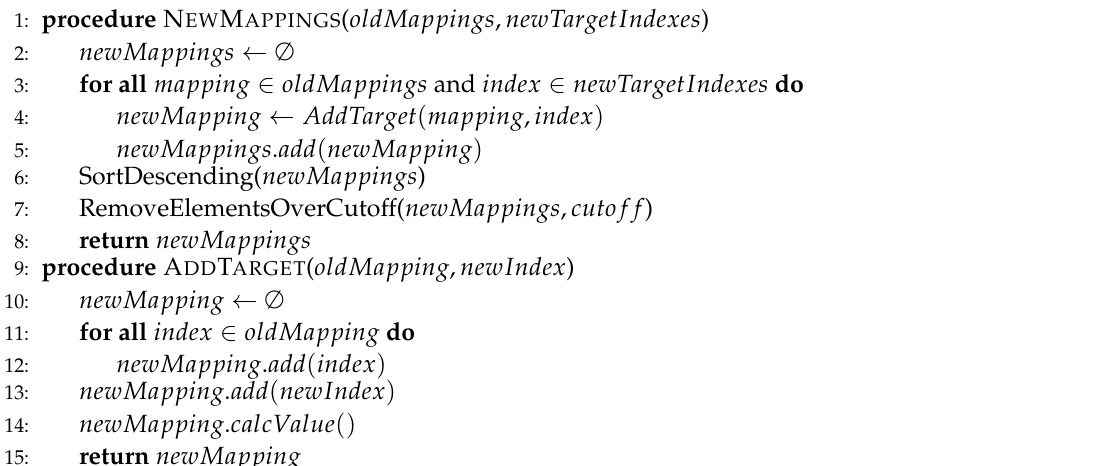
Algorithm 2 Iterative algorithm finding cuto f f best mappings after adding a new fixation with newTargetIndexes to mappings created so